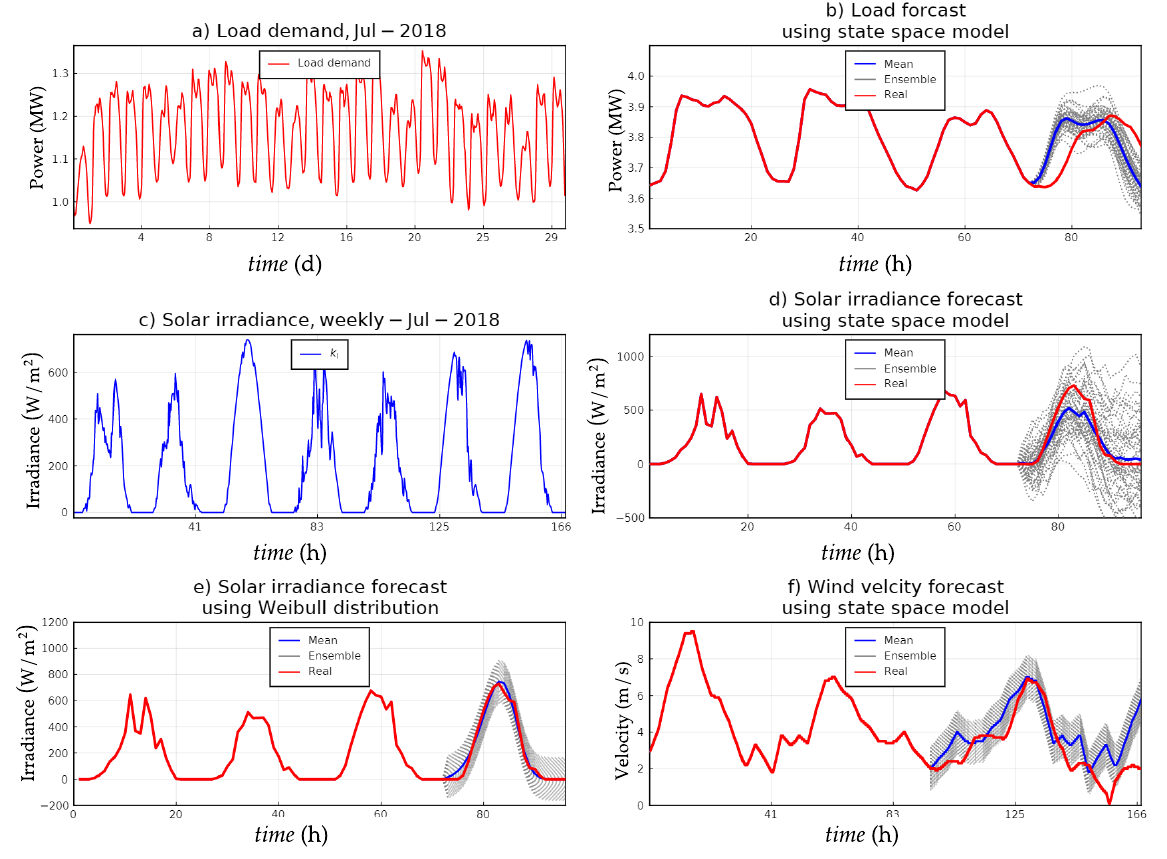
Figure 17. Forecasts for consumer load, solar irradiance, and wind velocity.